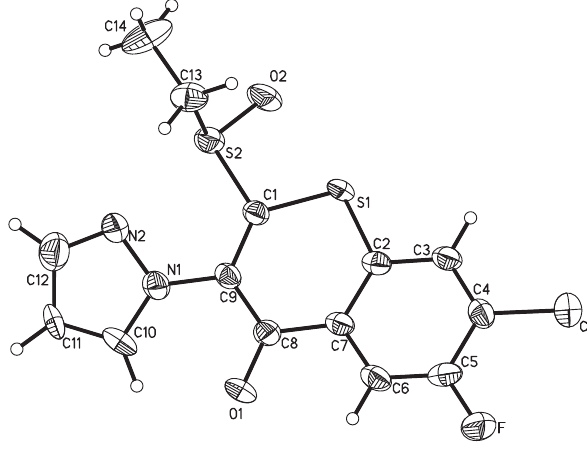
Table 1: Data collection and handling.